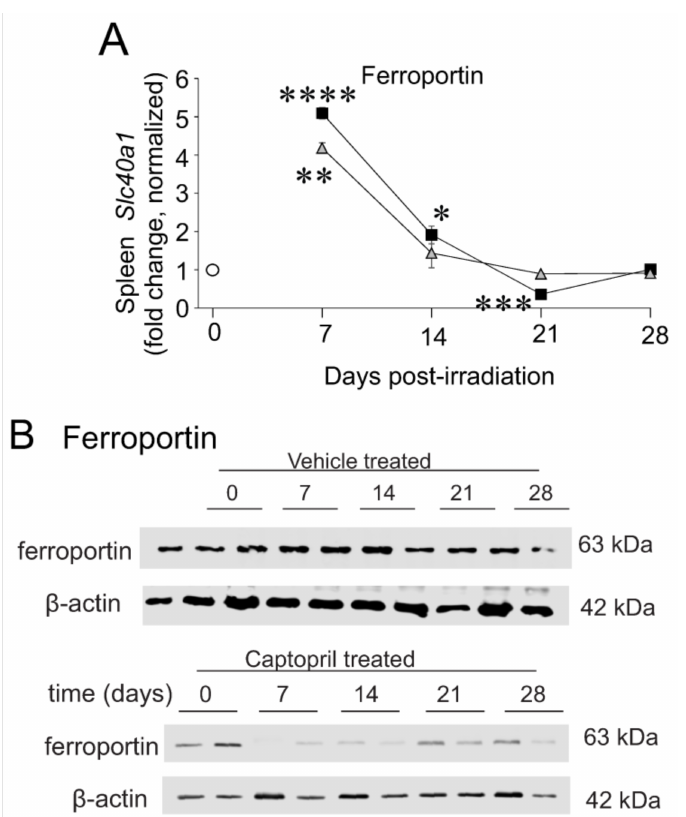
Figure 4. Total body irradiation results in increased gene expression of ferroportin but not ferro- portin protein. C57BL/6 mice were exposed to 6.85 Gy total body irradiation. Animals received vehicle (drinking water alone) or captopril in the drinking water on days +2–+16 post-irradiation. At the indicated time points, mice were euthanized, and spleen tissue was obtained for RNA and protein analysis. ( A ) qPCR was performed Slc40a1 (ferroportin). Graphs show means ± SEM from n = 4 animals per group. Asterisks: * indicates p < 0.05 from control (sham irradiated) levels; ** indicates p < 0.01 from control; *** indicates p < 0.001 from control; and **** indicates p < 0.0001 from control. ( B ) Western blotting of ferroportin. Blots were probed for β -actin as a loading control. Representative data are